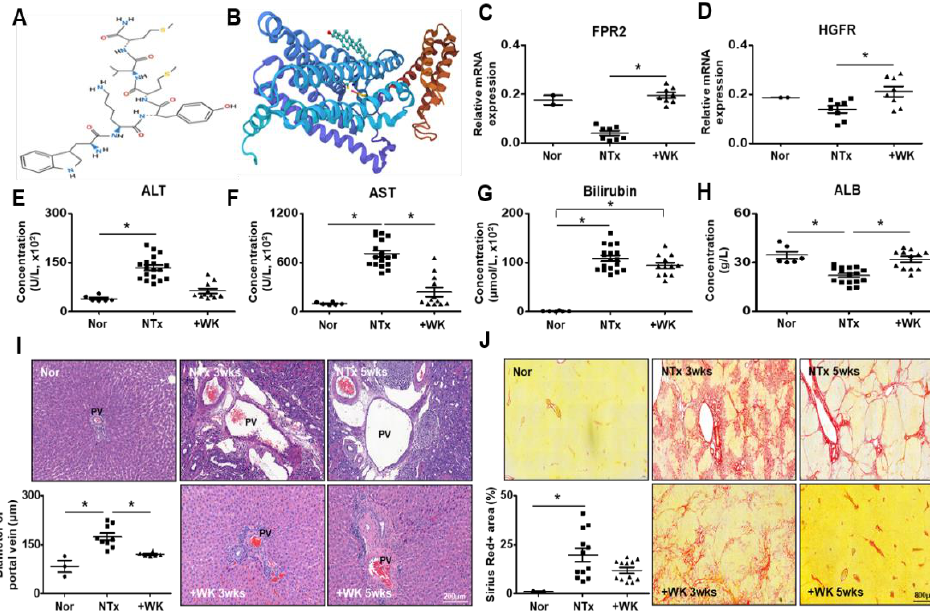
Figure 1. WKYMVm attenuates pathologic changes caused by bile duct ligation (BDL). ( A ) 2D structure of WKYMVm. ( B ) 3D structure of WKYMVm with FPR2. ( C , D ) The mRNA of FPR2 and HGFR in the livers of normal, BDL, and WKYMVm-treated BDL rats were analyzed by qRT-PCR. ( E – H ) The level of hepatic function markers in the BDL rat serum was analyzed. ( I ) H&E staining of liver sections. Scale bar: 200 μm. The diameter of the portal vein was quantified. ( J ) Sirius Red staining. Scale bar: 800 μm. The Sirius Red-positive area was quantified as the percentage of the total area. Mean ± SD ( n = 3 per group),* p < 0.05; one-way ANOVA. Nor, normal control group; NTx, untreated BDL group; +WK, WKYMVm-treated BDL group; PV, portal vein; wks, weeks.